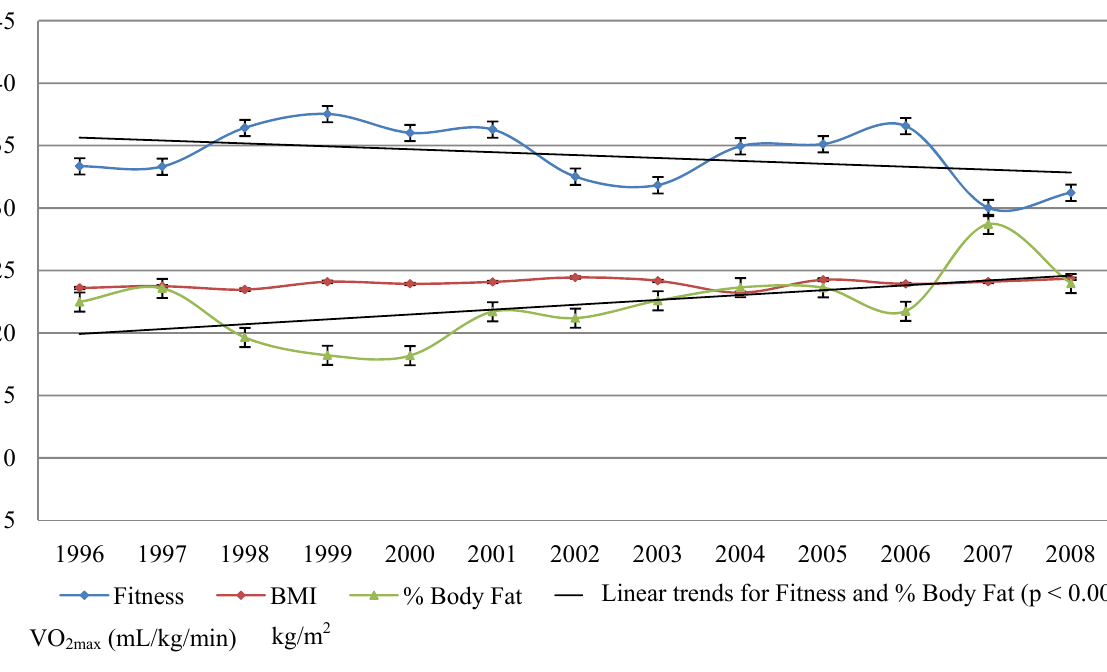
Linear trends for Fitness and % Body Fat (p < kg/m 2 Figure 2. Trends in physical fitness, BMI and % body fat in females (1996–2008).